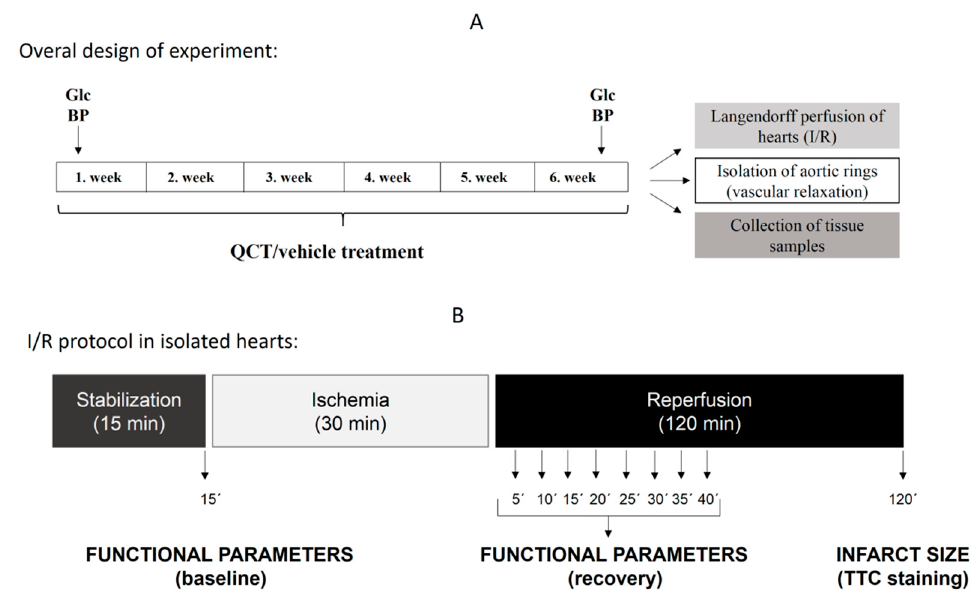
Figure 8. Overall experimental design ( A ) and experimental protocol of I / R in isolated hearts ( B ). Abbreviations: Glc, fasting glycaemia measurements; BP, blood pressure measurements.